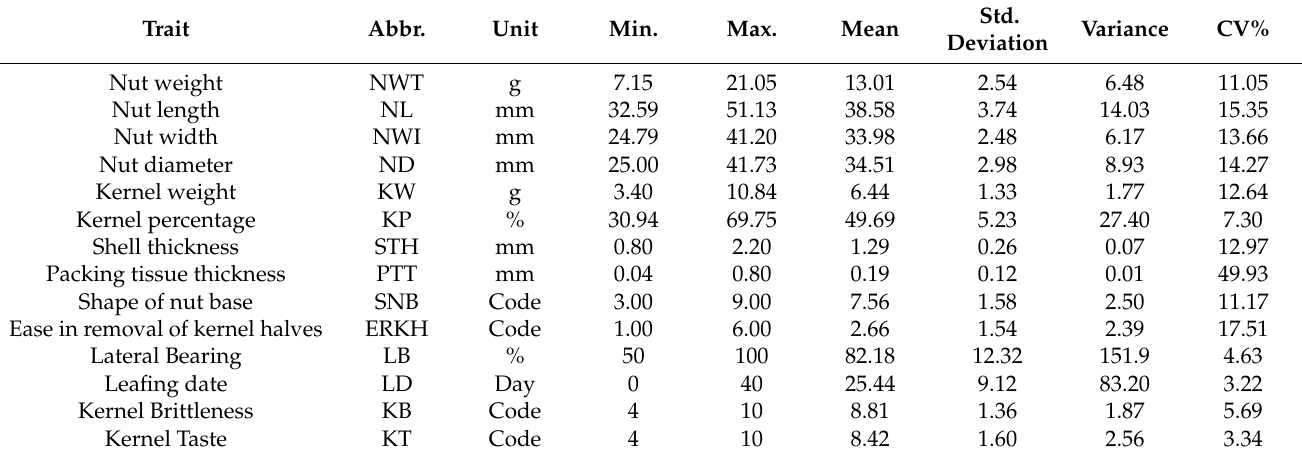
Table 3. Descriptive analysis of examined traits in 47 Persian walnut genotypes. (two-year mean